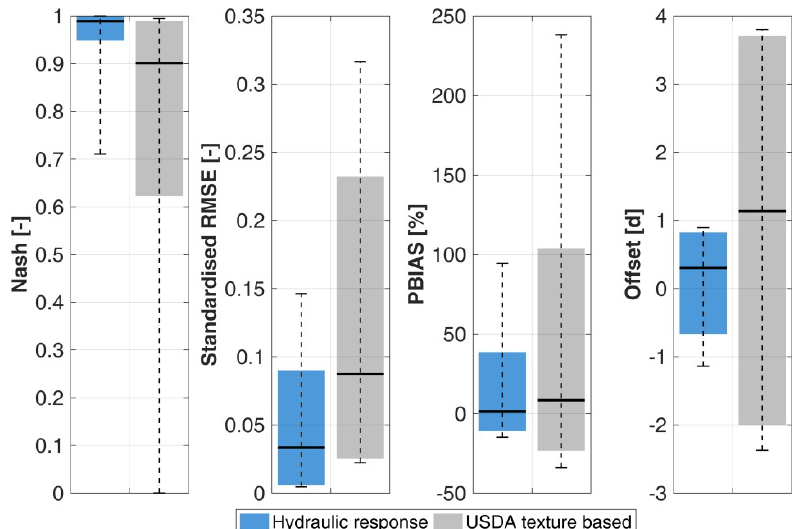
Figure 6. Bandwidth of the quality criteria Nash, RMSE (standardized), PBIAS (percentage error) and Offset (blue = evaluation based on hydraulic response classes; grey = based on USDA classes). The optimal value of Nash is one; the optimal values of RMSE, PBIAS, and Offset are zero. The horizontal black lines show the mean quality values of all classes. The boxes show the mean values ± two times standard deviation (cut at a value of one) and the whiskers symbolise the minimum and maximum values.